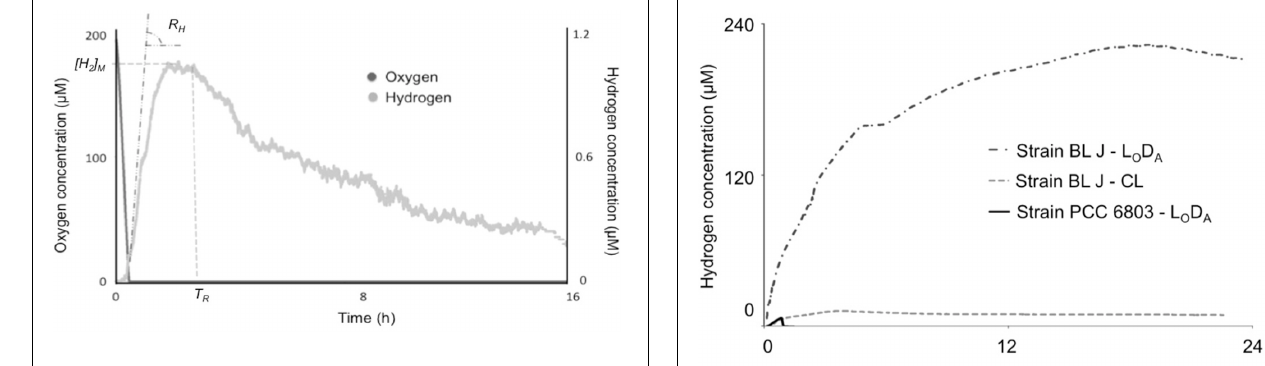
FIGURE 1 | Oxygen and hydrogen concentrations during a fermentative H 2 production assay in Synechocystis sp. PCC 6803. Anoxia is established in a few minutes by respiration in dark followed by onset of fermentative H 2 production. The parameters of H 2 production studied are the maximal initial rate of H 2 production, R H , the maximum steady-state H 2 concentration [H 2 ] M , and the time, after which hydrogenase reverses in direction, T R .